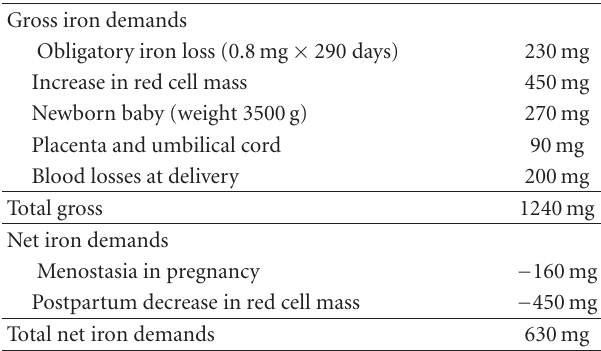
Table 1: Iron balance in normal pregnancy and delivery, approxi- mate